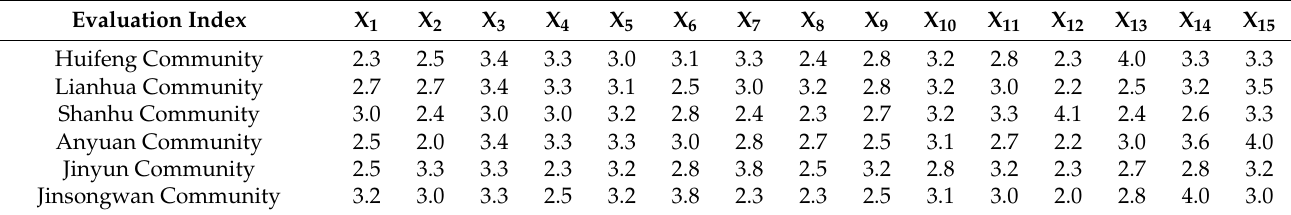
Table 4. The score of new centralized community public space satisfaction.